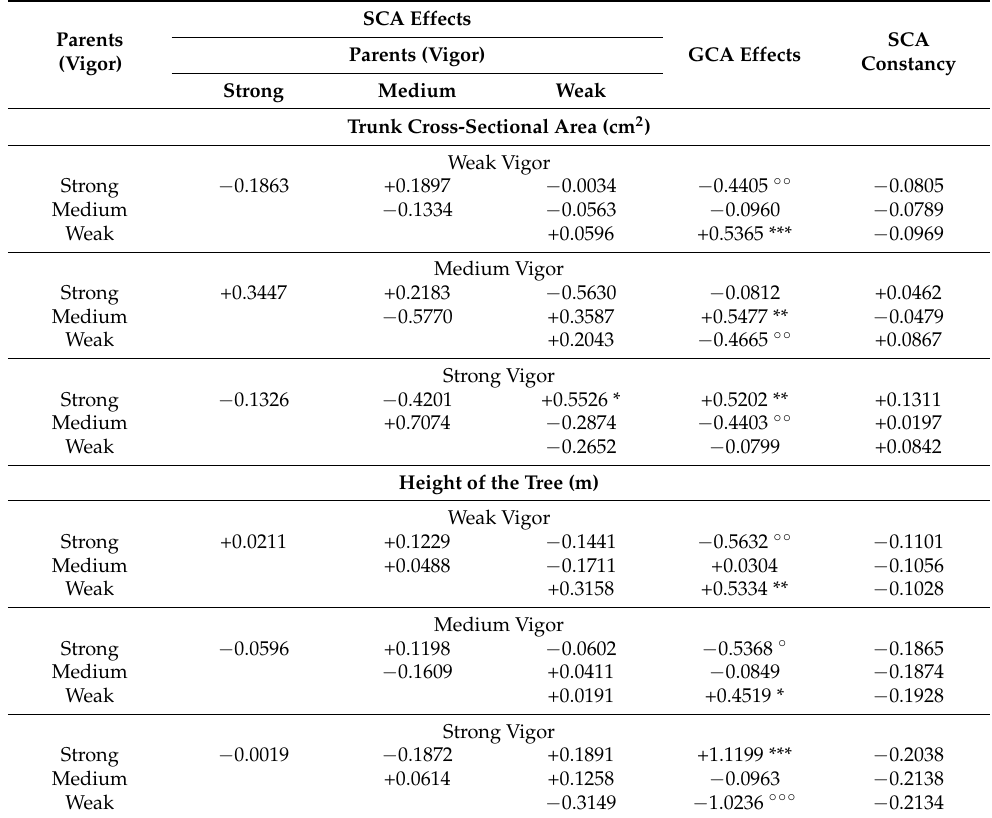
Table 3. The effects of general combining ability (GCA) and specific combining ability (SCA) on the vigor of F 1 apple hybrids expressed by the cross-sectional area of the trunk and tree height and depending on the vigor of the parent varieties.